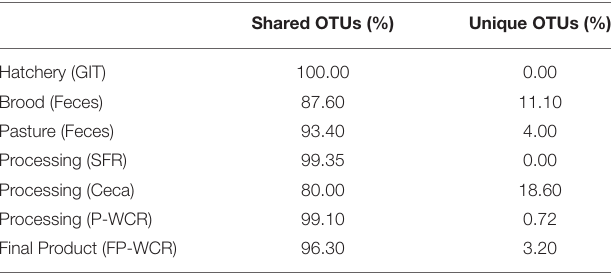
TABLE 2 | Shared (found in at least two sample types) and Unique (found in only one sample type) OTUs found within the core microbiome found in at least 50% of the different sample types and stages along the farm-to-fork continuum of a pasture-raised broiler flock a .